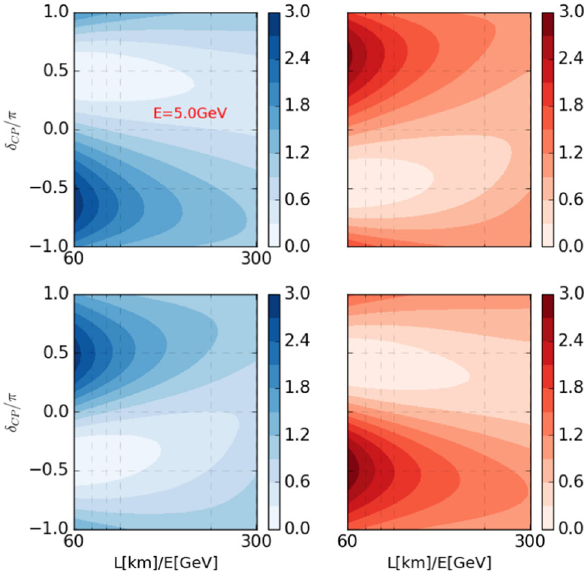
Fig. 6 Same as Fig. 5 but the reference energy E = 2 . 0 GeV has been fixed to the NO ν A flux peak energy. For this peak energy and NO ν A baseline, L / E = 405